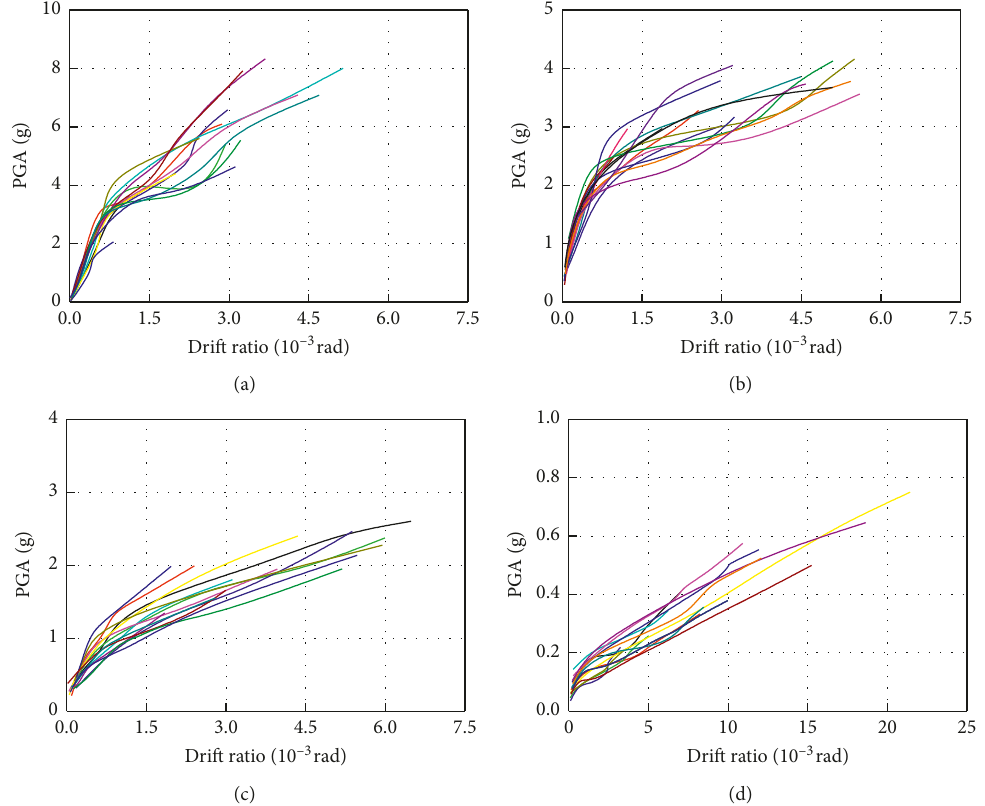
Figure 12: IDA curves in terms of PGA as IM. (a) Site I. (b) Site II. (c) Site III. (d) Site